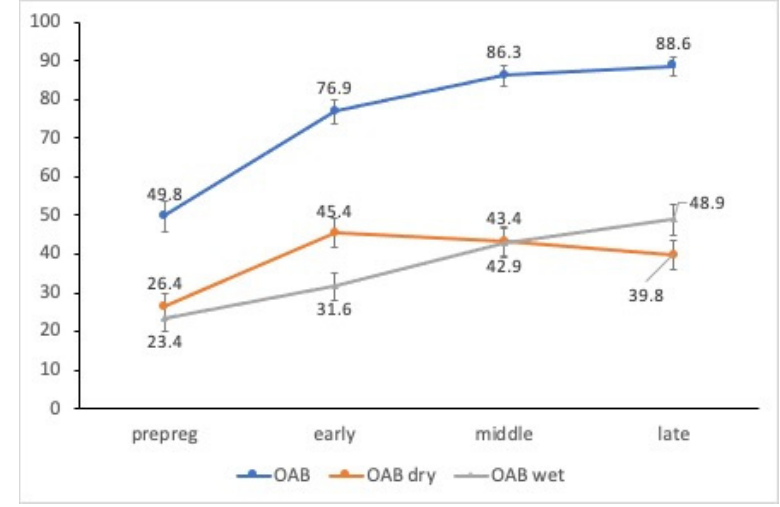
Figure 1. Prevalence of OAB, OAB-dry, and OAB-wet during early, middle, and late pregnancy. Table 3. Changes in the prevalence of OAB.